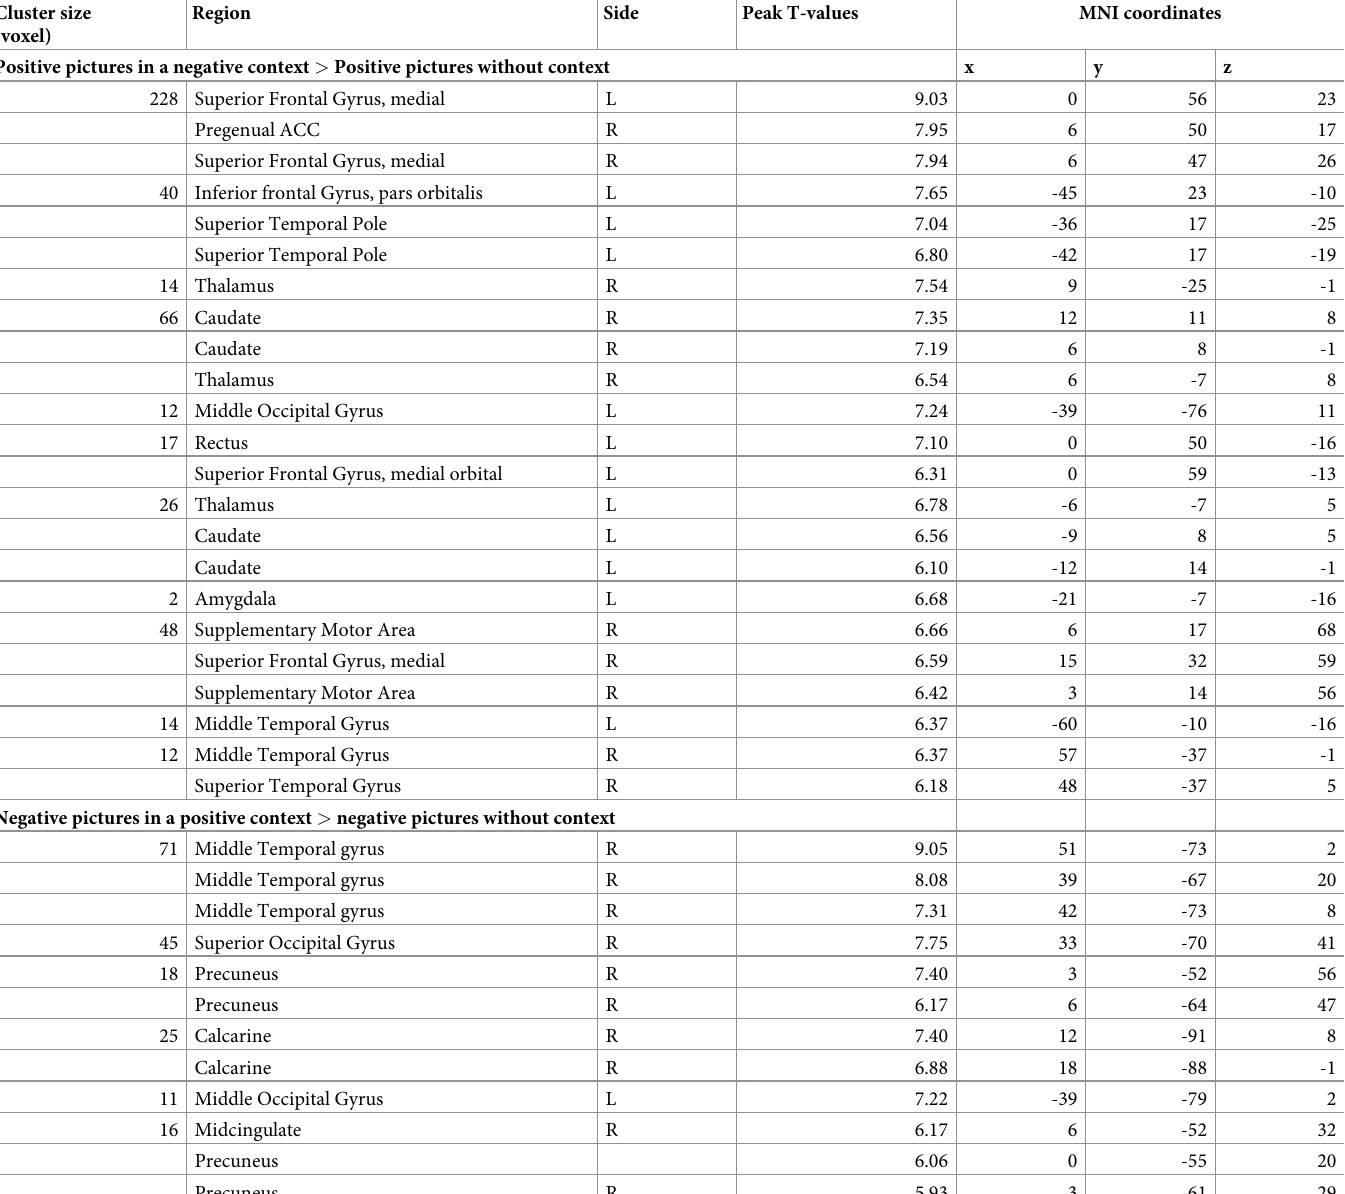
Table 2. Brain regions showing increased activation to positive pictures in a negative context compared to positive pictures without context and brain regions show- ing significantly increased activation to negative pictures in a positive context compared to negative pictures without context. Cluster size